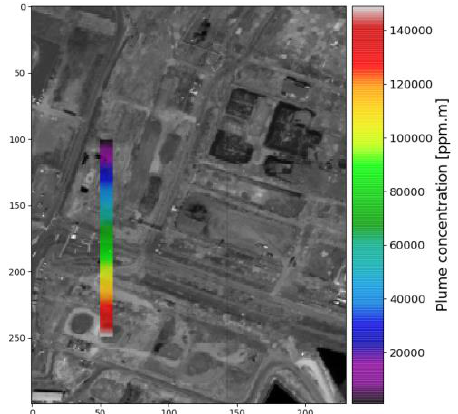
Figure 4 . Semi-synthetic radiance image displayed at 1538 nm in grey scale. The concentration of the methane plume, in ppm.m, is superimposed in colour